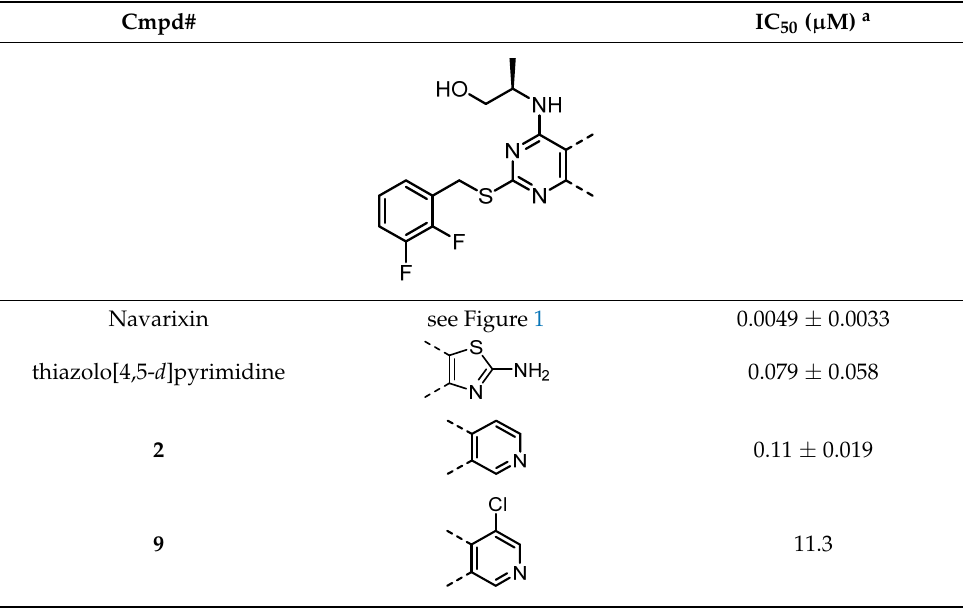
Table 1. CXCR2 antagonism of 5- and 6-substituted pyrido[3,4- d ]pyrimidines. Cmpd#